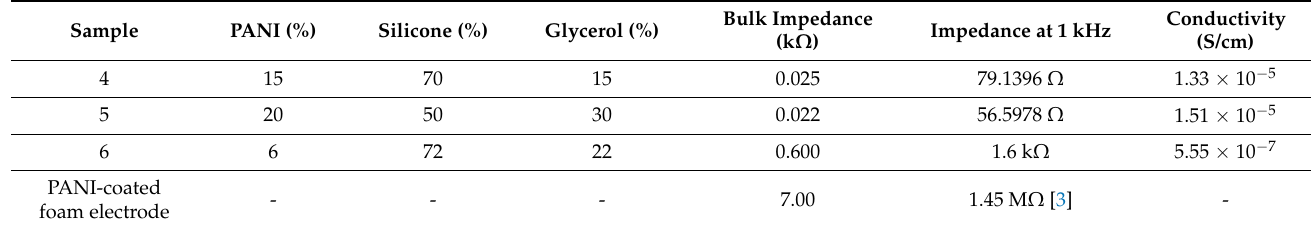
Table 4. Comparison between different prepared electrode samples.